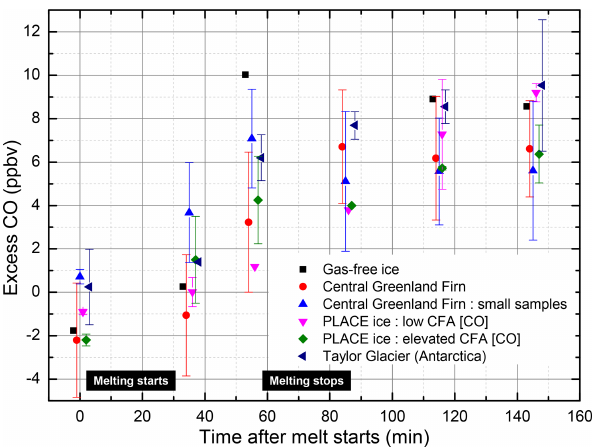
Figure 3. Average excess in the CO mixing ratios produced during the melting of discrete samples measured by gas chromatography combined with a mercuric oxide reduction detector. The CO values shown have been corrected for a small ( ∼ 3ppbv) CO excess ob- served in equivalent tests where the ice samples were not melted (see Sect. S1.11.3). The following samples are investigated: gas- free ice, firn from central Greenland (including low-mass samples), PLACE ice samples exhibiting high CFA [CO] and low CFA [CO], and Taylor Glacier (Antarctica) ice. The samples’ descriptions are reported in Table S4. Error bars represent 1 standard deviation for all sample runs of a given type, and points without error bars repre- sent single